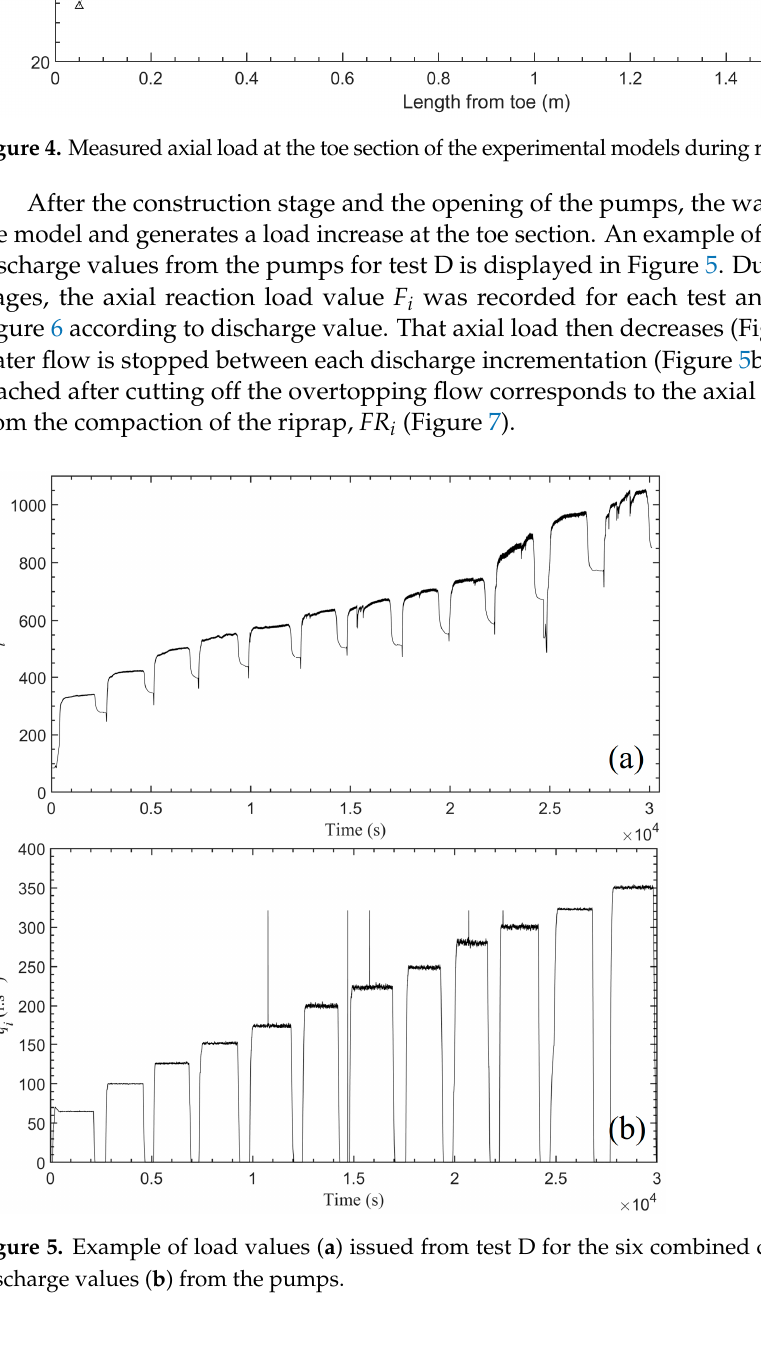
Figure 6. Axial load at the toe section during overtopping event for each of the five tests ( a − e ) and for all the tests ( f ) according to discharge values.